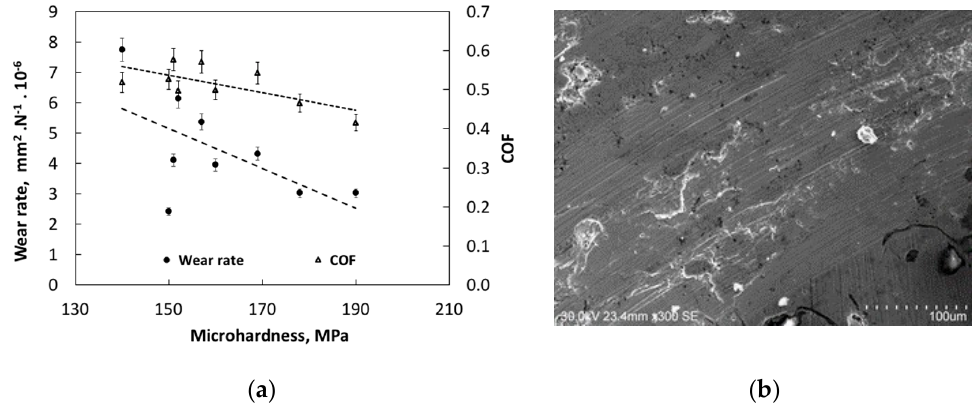
Figure 8. ( a ) Results of the wear rate and coefficient of friction (COF) vs. the microhardness HV in the ball-on-disk test; ( b ) SEM micrography of the wear fingerprint with ball-on-disk test (the trend lines are shown as a visual aid).